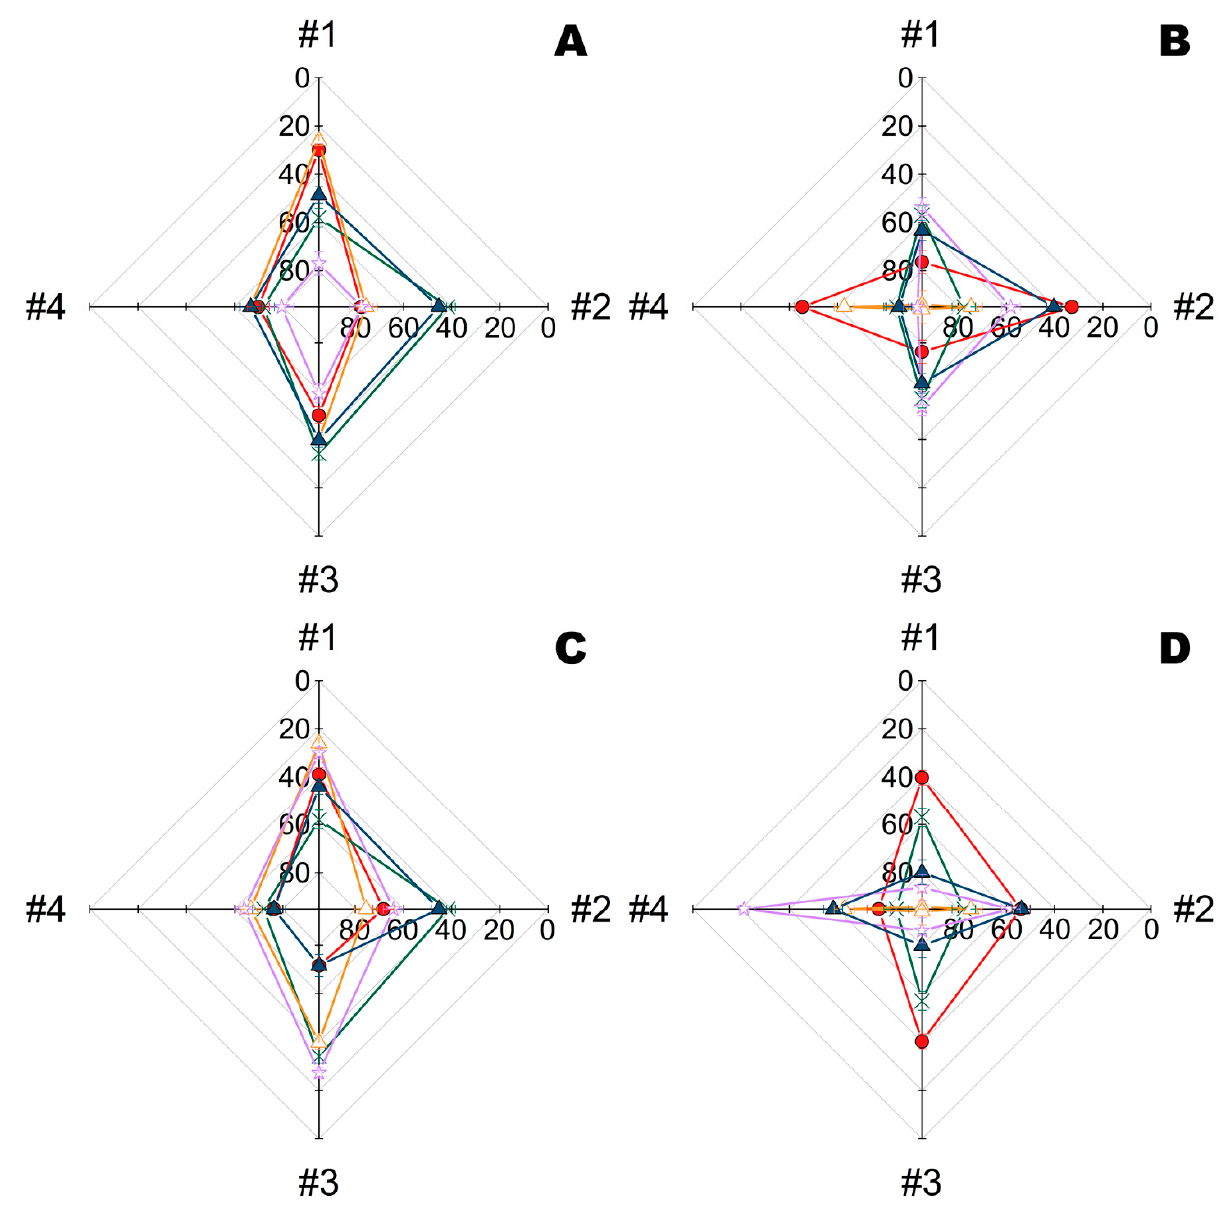
Figure 6. Residual intracellular ATP quantity (%) in B. subtilis ( A , C ) and E. coli bacterial cells ( B , D ) exposed for 24 h on multiple fiber materials (#1, #2, #3, and #4) treated with polymyxin B ( A , B ) or